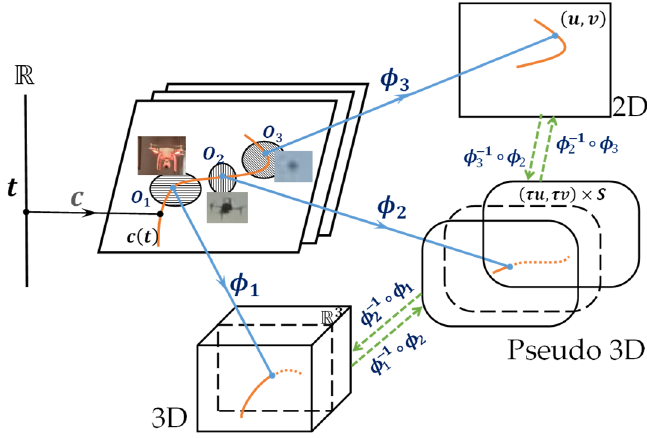
Figure 6. Illustration of the compatibility.